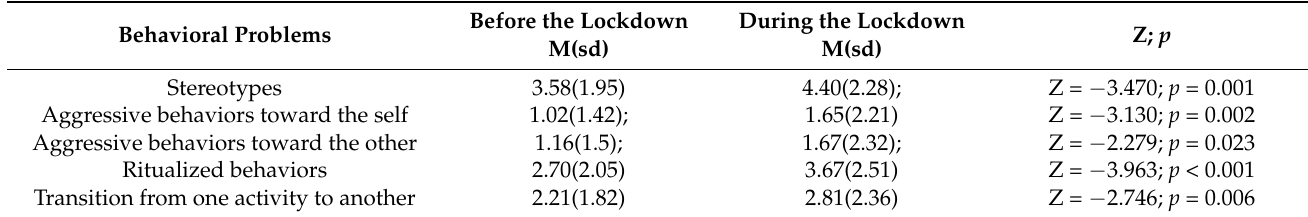
Table 4. Comparison between before and during the lockdown in behavioral